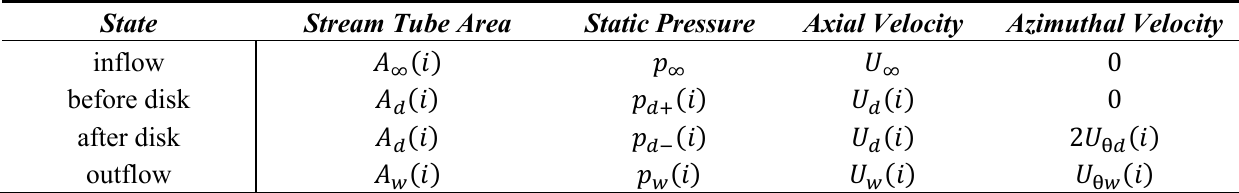
Figure 1. Horizontal-axis wind turbine (HAWT) control volume of a radial element (stream tube). The wake part of the element is marked by the streamlines emanating downstream of in the fully developed wake. Table 1. Stream tube states and